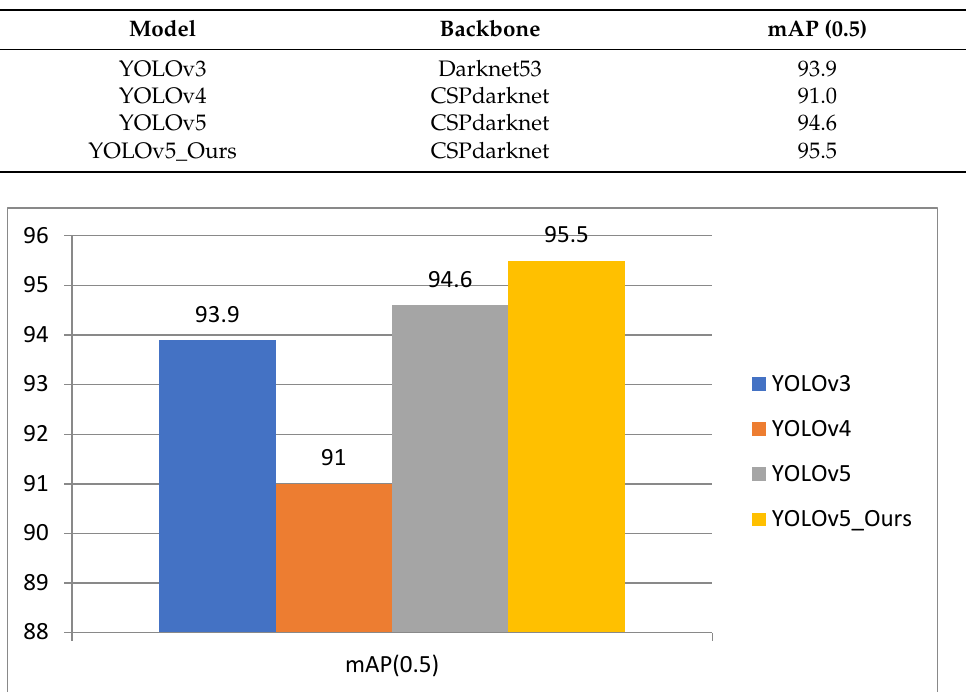
Figure 14. Comparison graph of function loss for Original YOLOv5 and YOLOv5_Ours model.